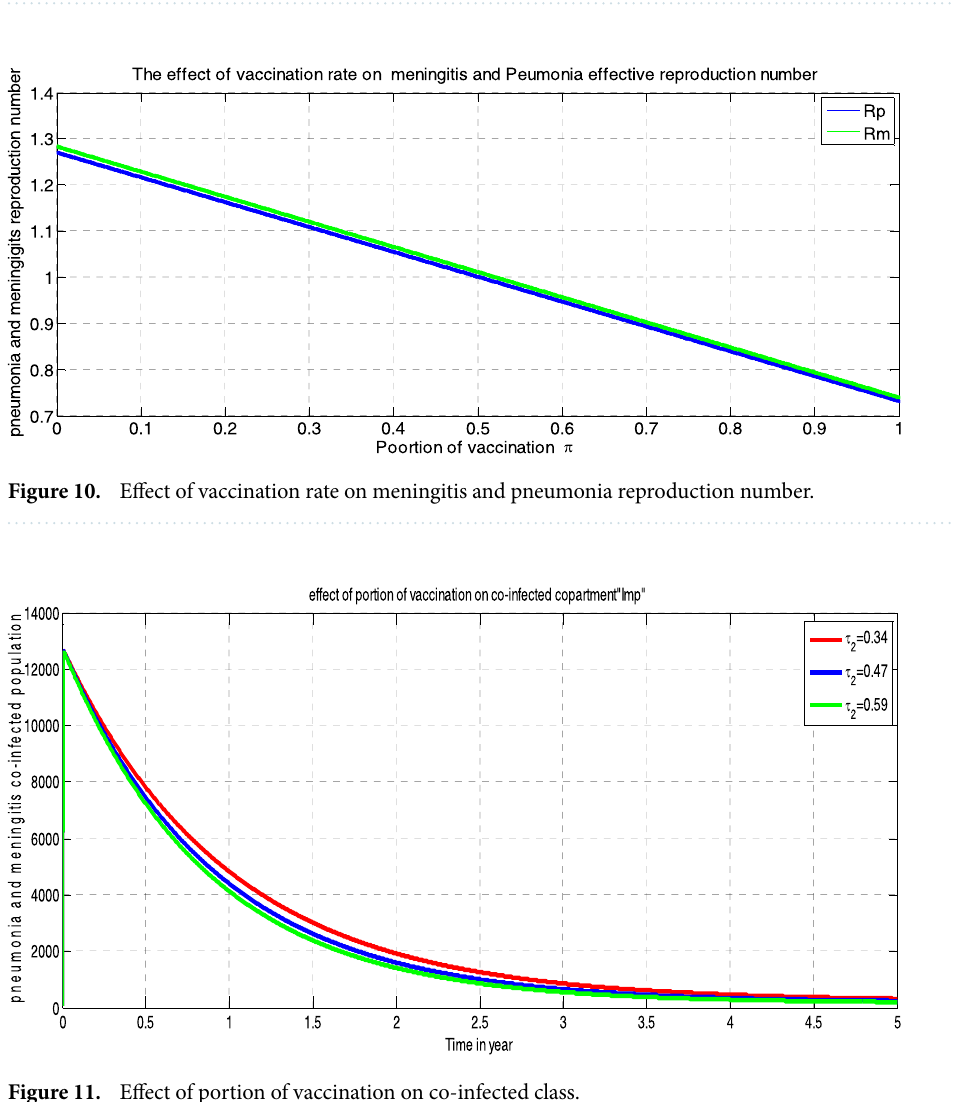
Figure 9. Effect of vaccination wanes on susceptible class.